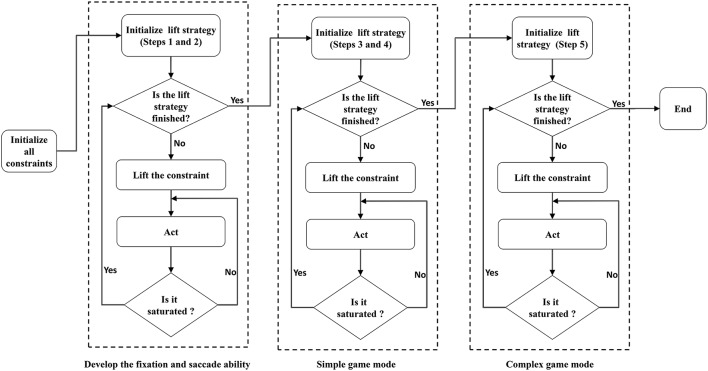
The LCAS algorithm implementation and the overall training processes.